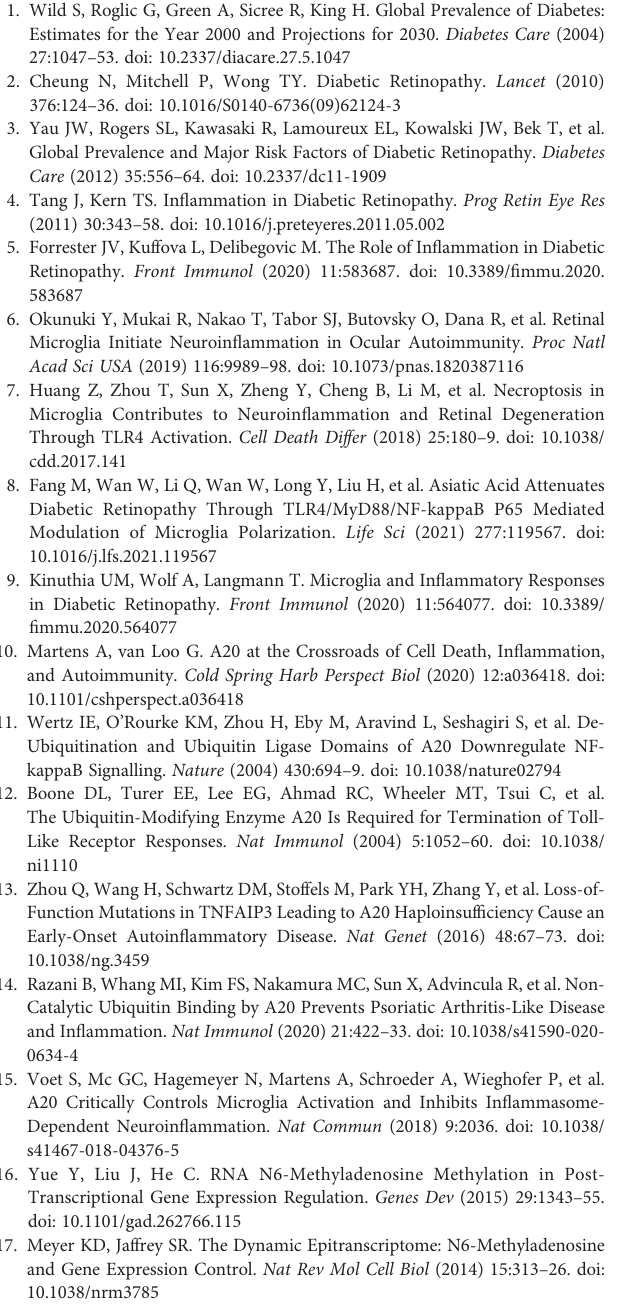
protein level compared to the Lv-NC. (C) OE-A20 increased the A20 mRNA level compared to the OE-NC. (D) OE-A20 increased the A20 protein level compared to the OE-NC. Values are presented as the mean ± SD. *** indicates P<0.001. Supplementary Figure 2 | The binding target site of A20 mRNA for ALKBH5. The luciferase activity of the mutant 2 group was restored to that of the control group. The luciferase activity of the mutant 1 and 3 groups, the same to the wild- type group,were signi fi cantly lowercompareto that ofthe control group.Values are presented as the mean ± SD. *** indicates